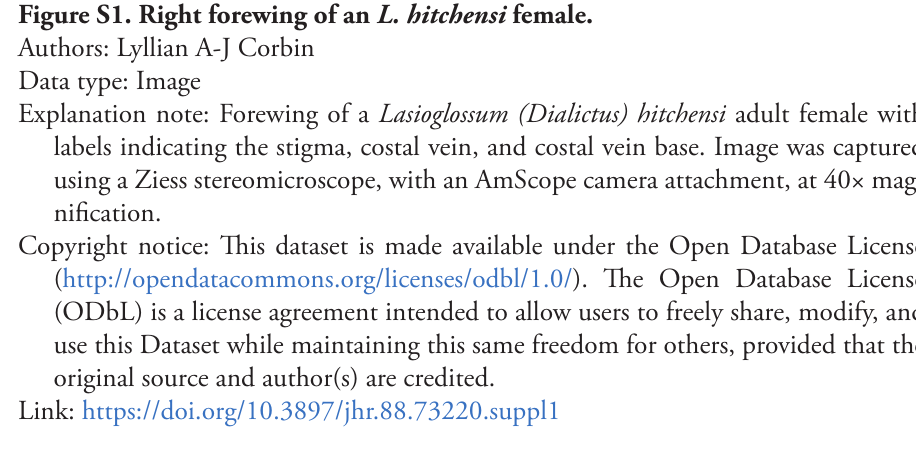
Figure S1. Right forewing of an L. hitchensi